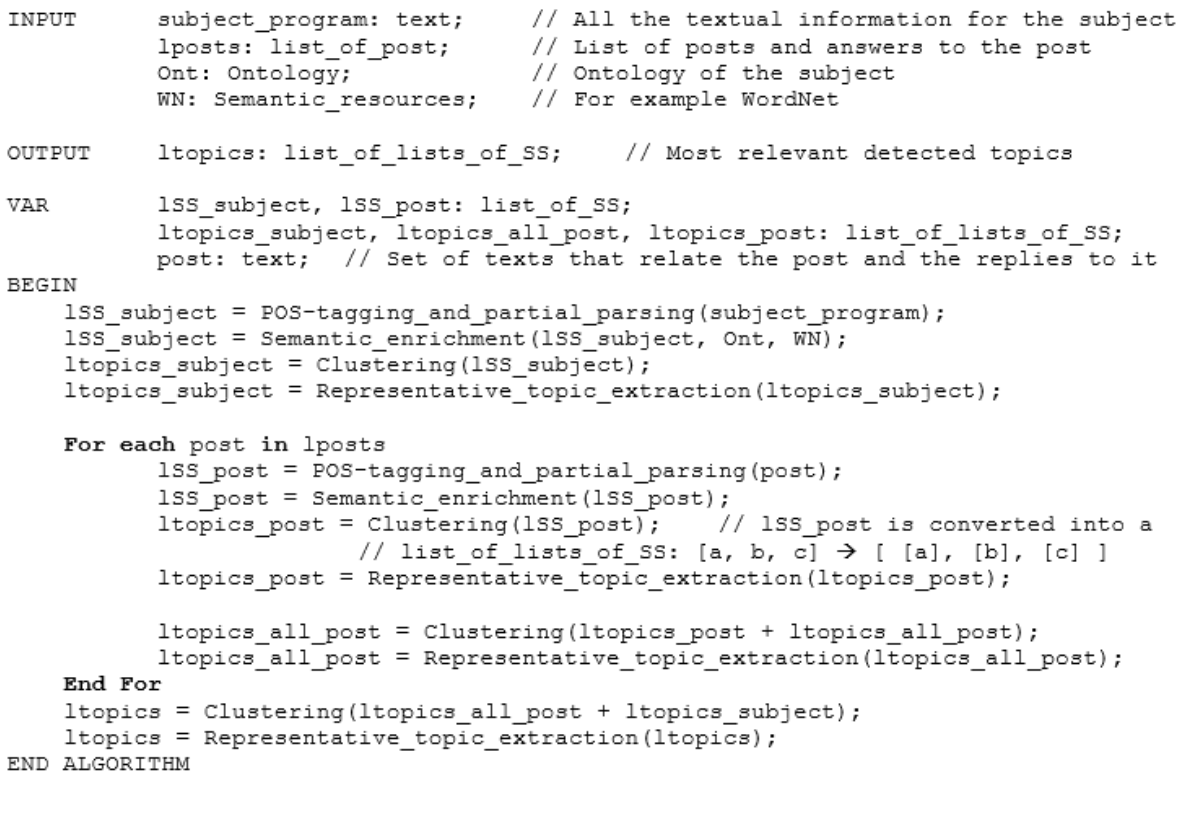
Figure 1. Topic detection method for a subject’s